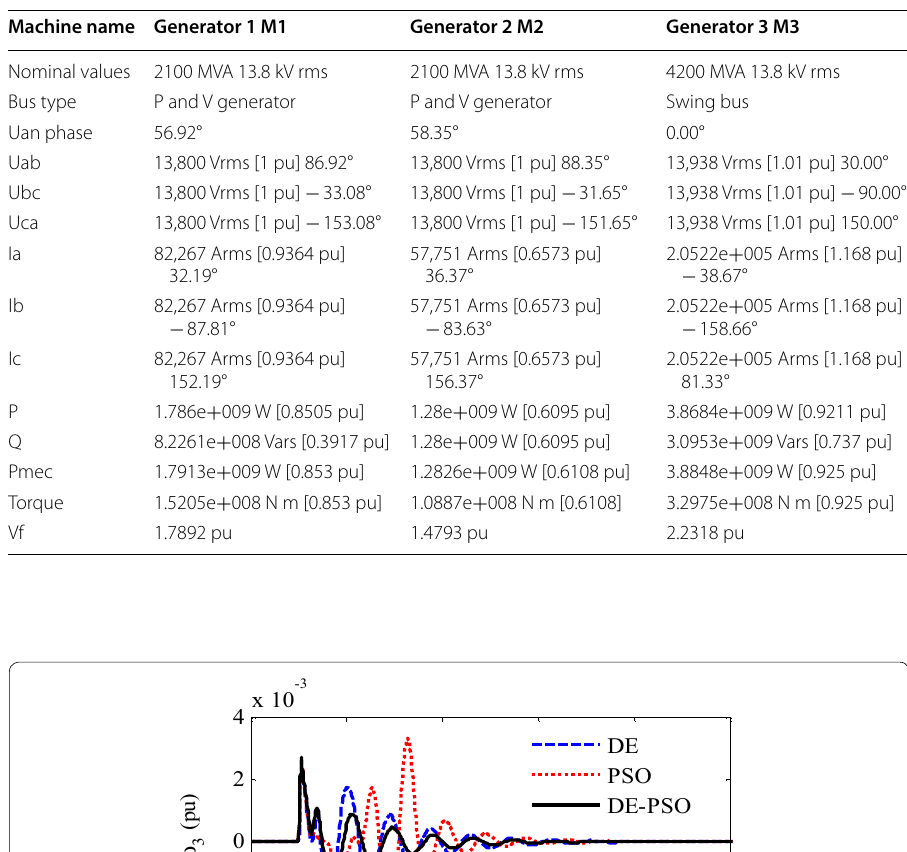
Table 2 Load flow and machine initialization